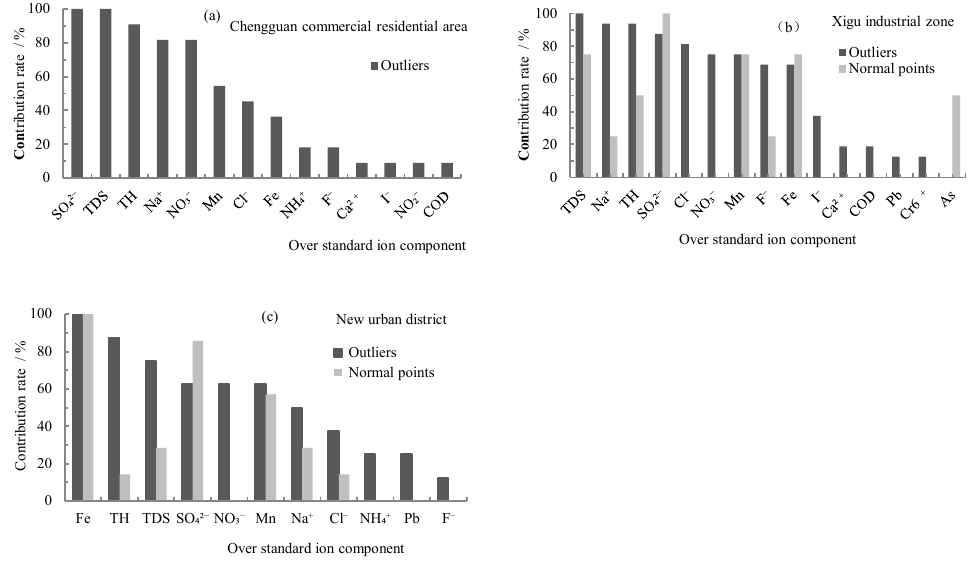
Figure 9. Contribution rate of the groundwater chemical super class III water index in different urban functional areas. ( a ) Index contribution rate in Chengguan area. ( b ) Index contribution rate in Xigu area. ( c ) Index contribution rate in New urban district.